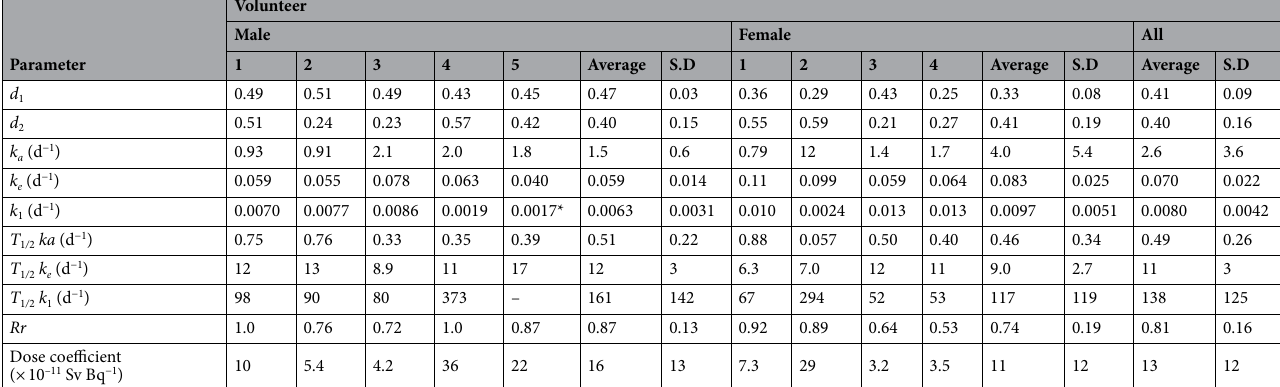
Fig. 1. Parameter values were determined by the least squares method except for the value accompanied with asterisk. *Presumed value of data that did not show a clear indication of the second component of exponential decrease.